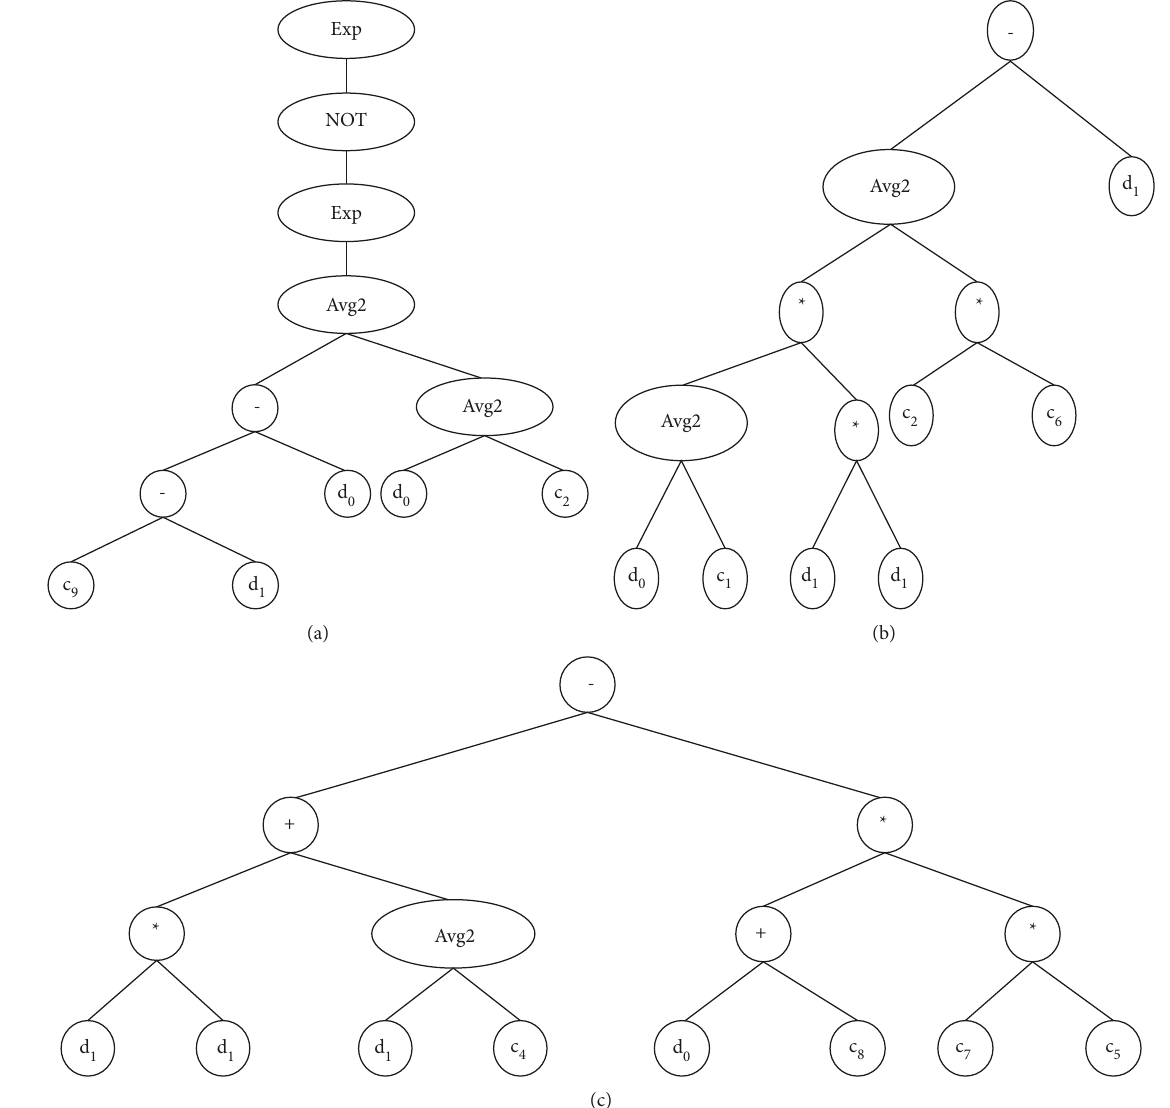
Figure 5: Subexpression tree diagrams. (a) Subexpression tree 1, (b) subexpression tree 2, and (c) subexpression tree